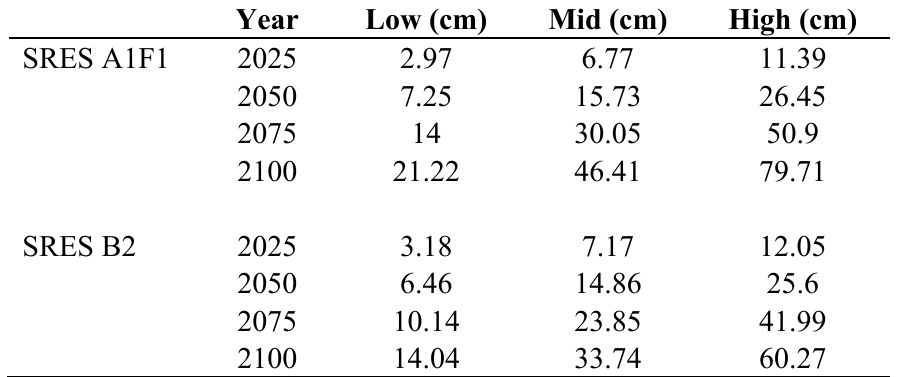
Table 3. Projected sea level rise (cm) for the 21st century under SRES A1F1 and B2 in study area.